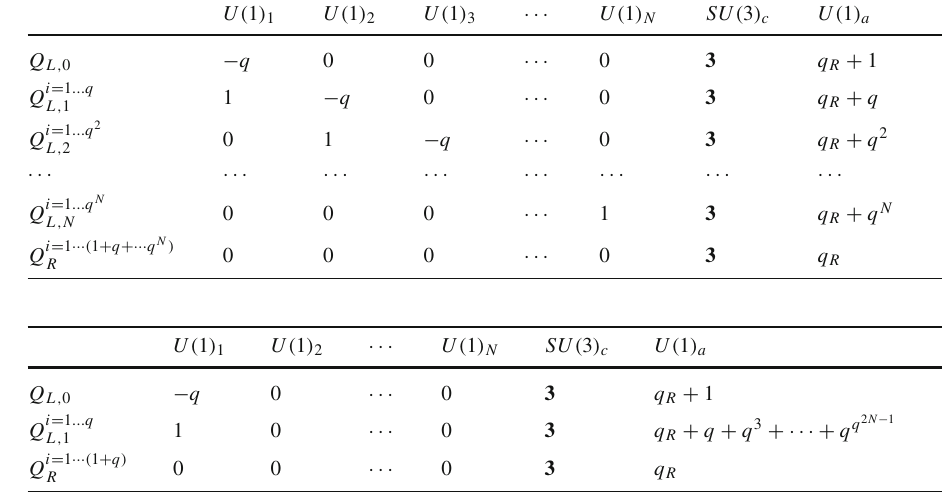
charged under the quiver gauge group of Fig. 1, canceling SU ( 3 ) 2 c − U ( 1 ) i anomalies and